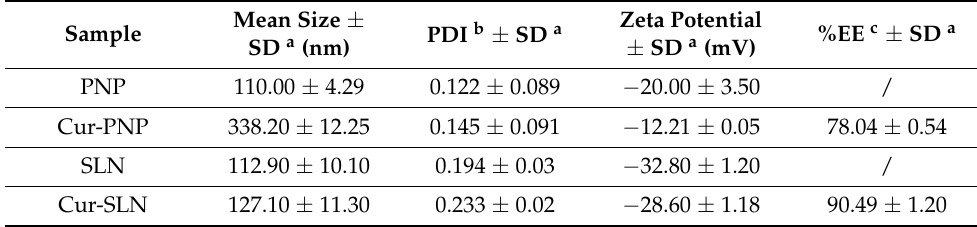
Table 1. Physico-chemical characterization and encapsulation efficiency of unloaded and curcumin (Cur)-loaded polymeric nanoparticles (PNP) and lipid nanoparticles